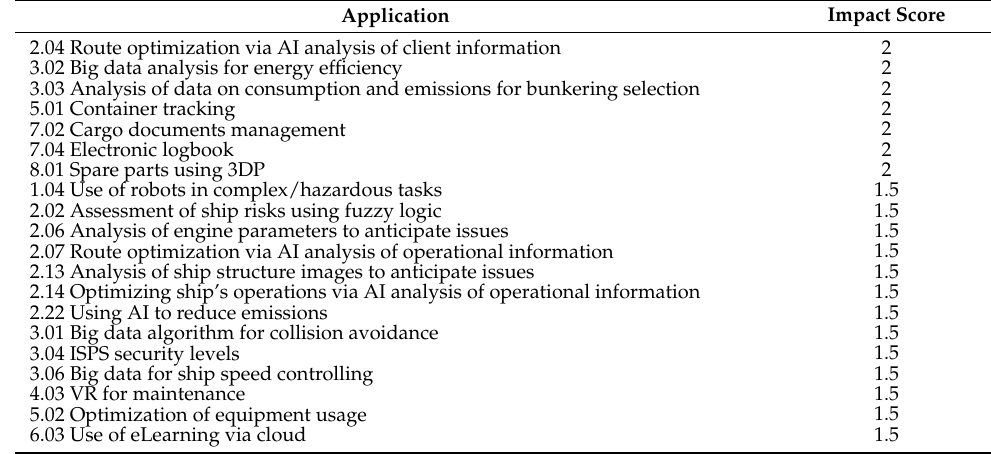
Table 8. Top applications on Cost performance dimension.